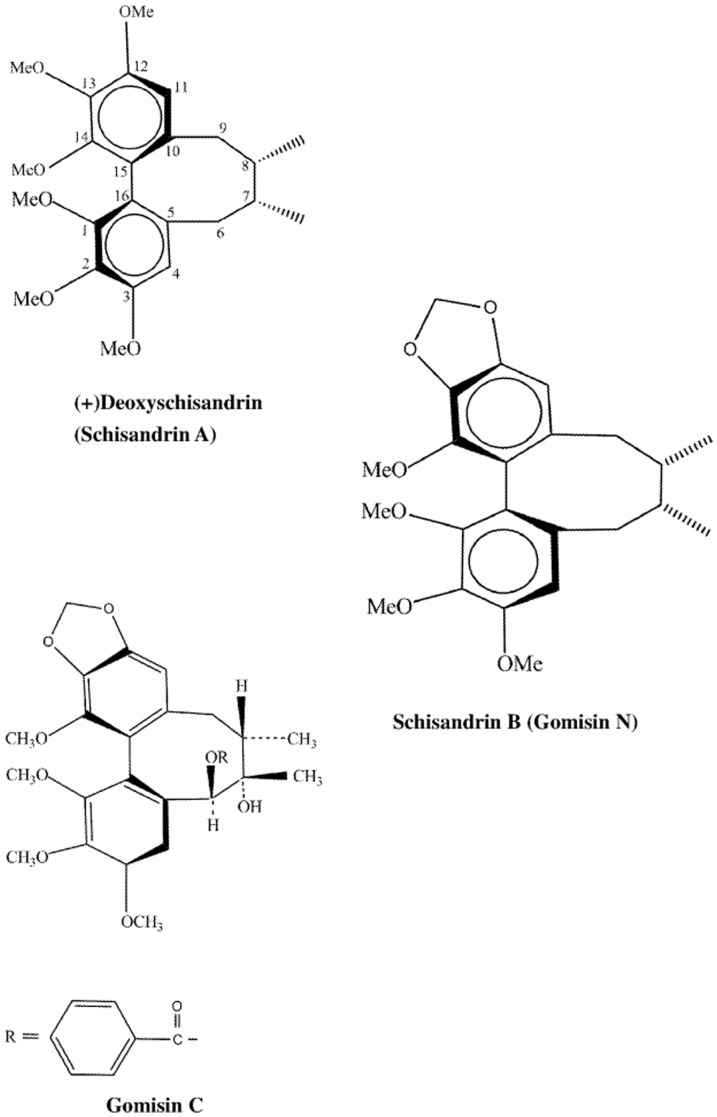
Chemical structures of liganas isolated from S. chinensis fruits.Gomisin C, deoxyschisandrin and schisandrin B isolated from the S. chinensis fruits. Structures of (+)deoxyschisandrin and (−)schisandrin B are depicted from Gnabre et al. (2010) [27]. Structure of gomisin C is depicted from Wang et al, (1994) [36].